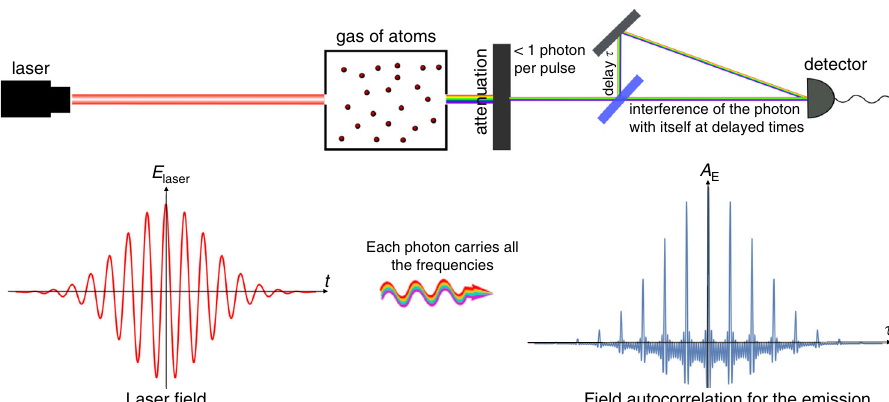
Fig. 6 Proposed autocorrelation experiment: scheme to observe that each high harmonic generation (HHG) is a frequency comb. HHG emission is fi rst created in a typical setup, e.g., where the source is a gas of atoms. We attenuate the output emission and measure the autocorrelation, varying the delay, for different levels of attenuation. If each photon carries the entire spectral content of the HHG emission, then the normalized autocorrelation function would be independent of the number of photons per HHG pulse, even when it is less than one photon on average per pulse (see Supplementary